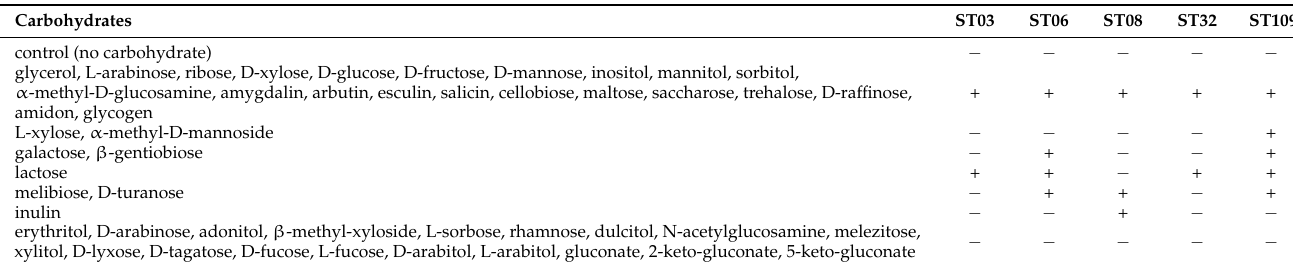
Table 2. Carbohydrate fermentation profile recorded for B. velezensis ST03, B. amyloliquefaciens ST06, B. subtilis ST08, B. velezensis ST32, and B. amyloliquefaciens ST109 based on API50CHB (BioMerieux). Carbohydrates ST03 ST06 ST08 ST32 ST109 control (no carbohydrate) − − − − − glycerol, L-arabinose, ribose, D-xylose, D-glucose, D-fructose, D-mannose, inositol, mannitol, sorbitol, α -methyl-D-glucosamine, amygdalin, arbutin, esculin, salicin, cellobiose, maltose, saccharose, trehalose, D-raffinose, + + + + + amidon, glycogen L-xylose, α -methyl-D-mannoside − − − − + galactose, β -gentiobiose − + − − + lactose + + − + + melibiose, D-turanose − + + − + inulin − − + − − erythritol, D-arabinose, adonitol, β -methyl-xyloside, L-sorbose, rhamnose, dulcitol, N-acetylglucosamine, melezitose, − − − − − xylitol, D-lyxose, D-tagatose, D-fucose, L-fucose, D-arabitol, L-arabitol, gluconate, 2-keto-gluconate, 5-keto-gluconate + Bacterial growth, evidence for fermenting the evaluated carbohydrate; − no bacterial growth.